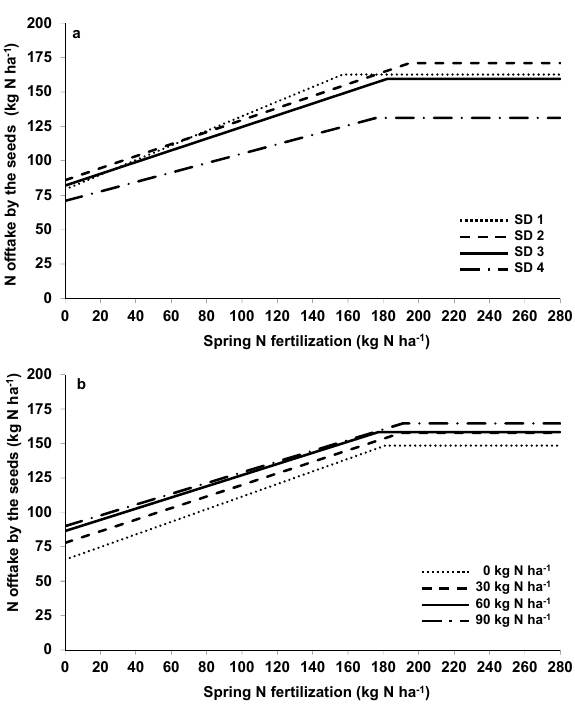
Figure 2. Effect of sowing method (SD) by spring N fertilization interaction ( a ) and autumn N by spring N fertilization ( b ) on N offtake by the seeds of oilseed rape (2010, 2011, 2013; for function parameters, see Table 2). (SD 1—first week of August; SD 2—third week of August; SD 3—first week of September; SD 4—third week of September).